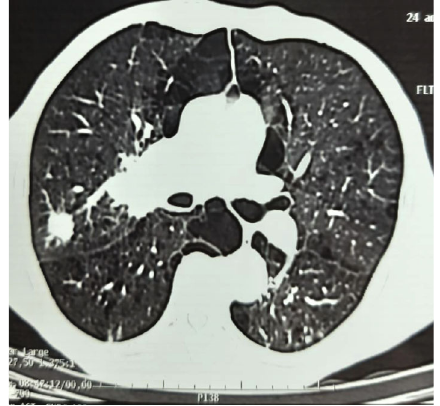
Figure 2: The thoracic computed tomography (CT) showed a right hilar tumoral process extended to the posterior segment of the right upper lobe of irregular and spiculated contours, associated with a spiculated nodule of the right upper